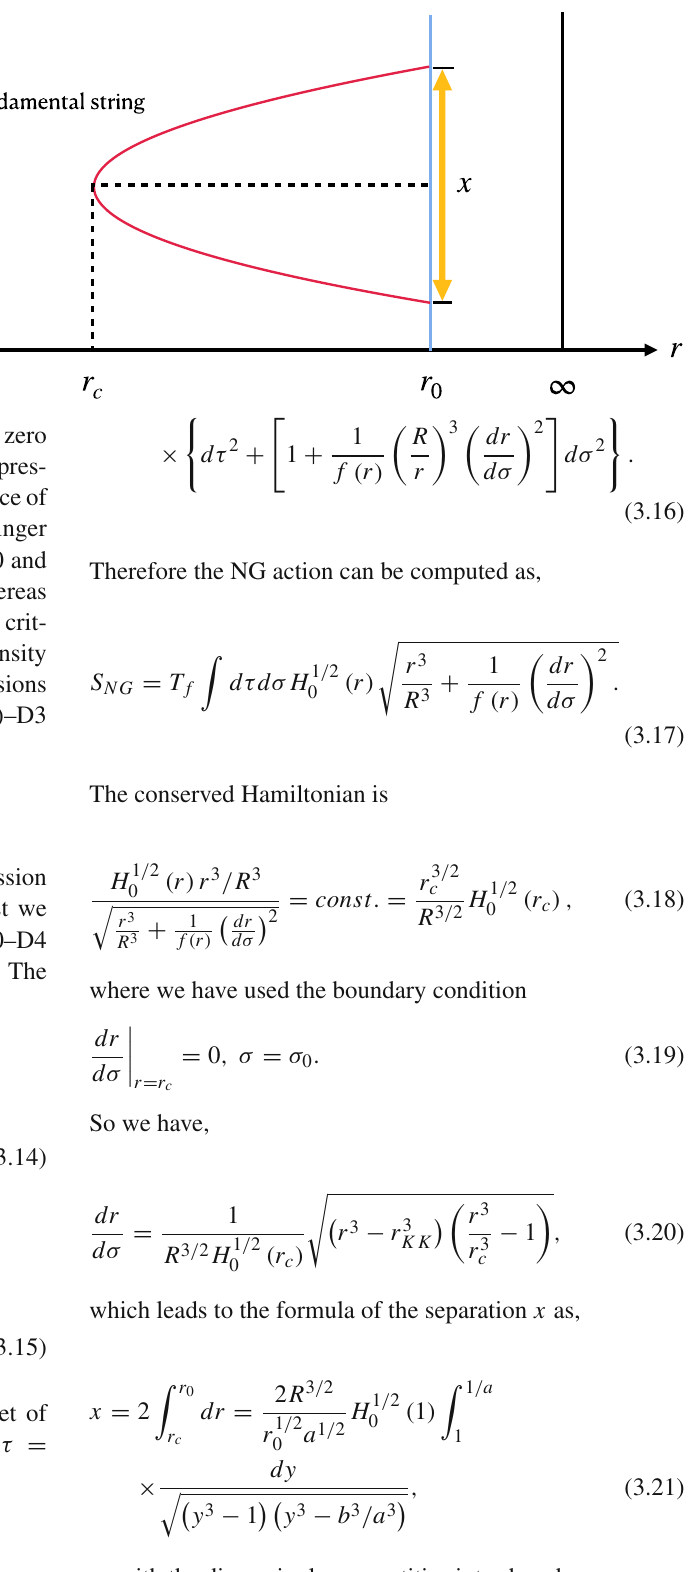
Fig. 1 Configuration of the string and probe